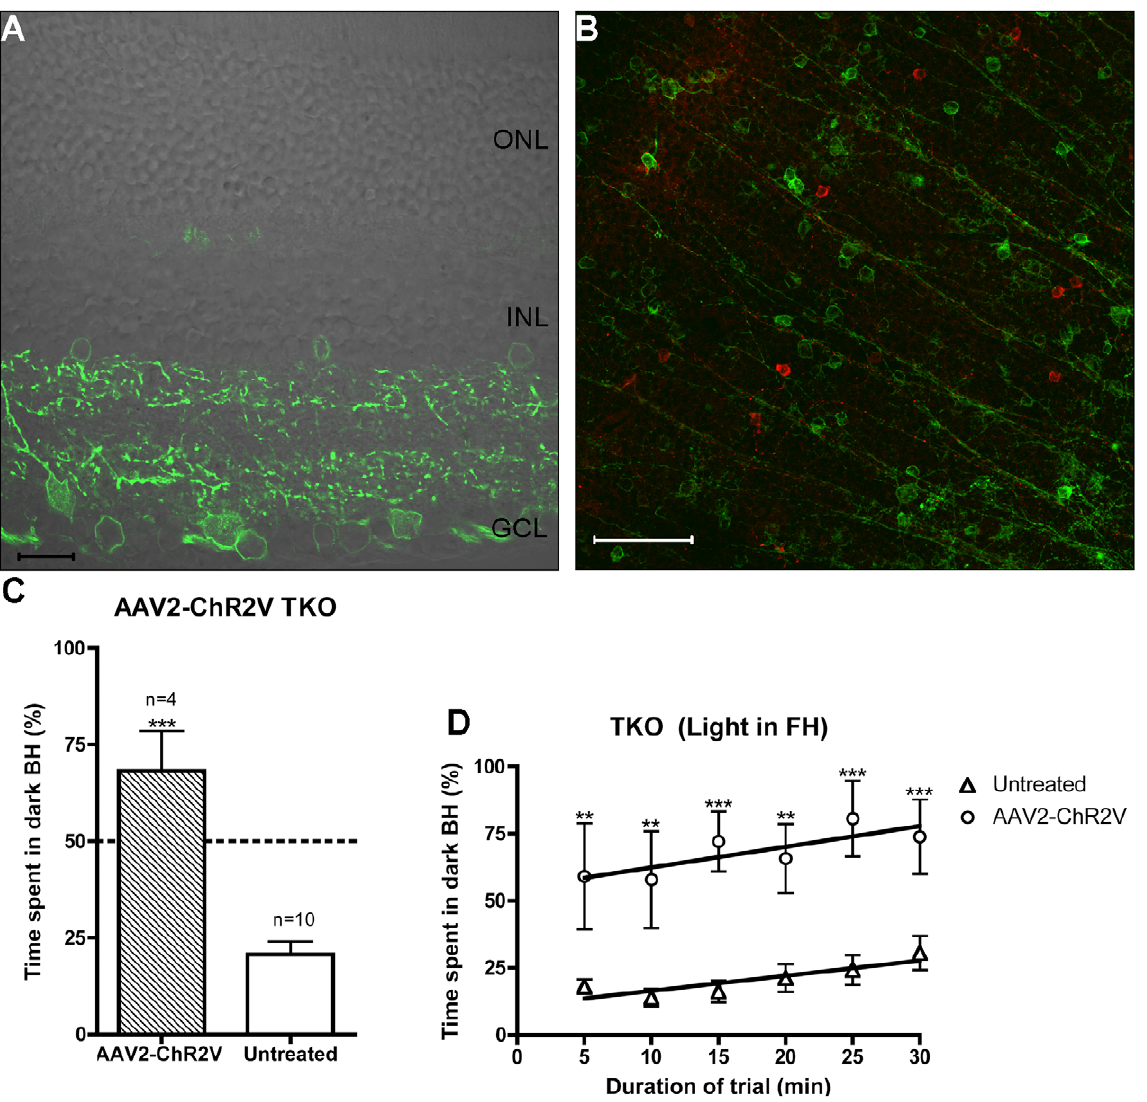
Figure 6. Channelrhodopsin-2 expression in the inner retina of TKO mice causes the induction of behavioural light aversion. ( A ) and ( B ) AAV2 transduced expression of Channelrhodopsin-2/Venus fusion (ChR2V) protein (green) in the ganglion cell layer of a TKO retina (AAV2- ChR2V TKO). ( A ) Transverse retinal section, ChR2V is visualised in many cells of the ganglion cell layer. Scale bar 20 m m ( B ) Immunohistochemistry on flat mount retina (focussing on the ganglion cell layer) for b -galactosidase (red) with ChR2V in green. Scale bar 100 m m. ( C–D ) Light aversion behaviour in the AAV2- ChR2V TKO. In these two graphs the comparison is between transduced and untreated animals when there is illumination in the front-half (FH). ( C ) Time spent in the dark back-half (BH) of the arena during the total 30 minutes of the trial. ( D ) Time spent in the dark (BH) of the arena over the course of the 30-minute trial. Stars (*) indicate significances (** p , 0.01; *** p , 0.001).